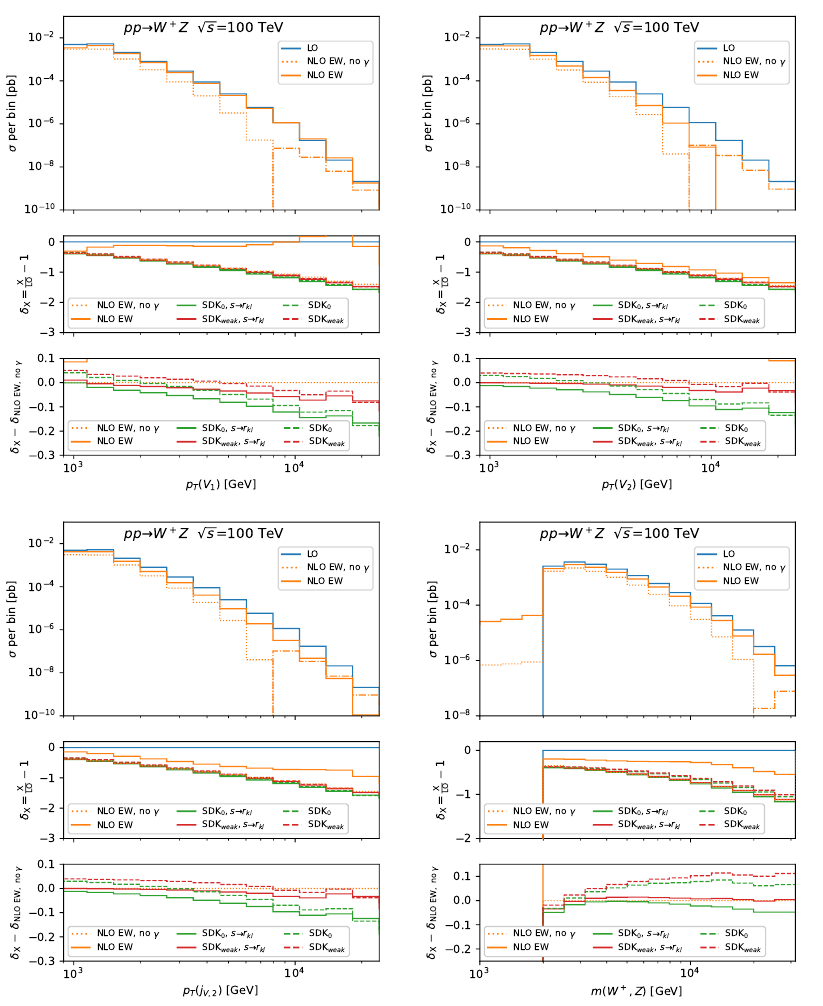
Figure 7 . Differential distributions for recombined V bosons in W + Z production at 100 TeV. Comparison between exact NLO EW predictions excluding photon-initiated processes (dotted orange) and their LA approximations in the SDK weak (red) and SDK 0 (green) approaches, including (solid) or excluding (dashed) the SSC s ! r kl terms. More details are given in the